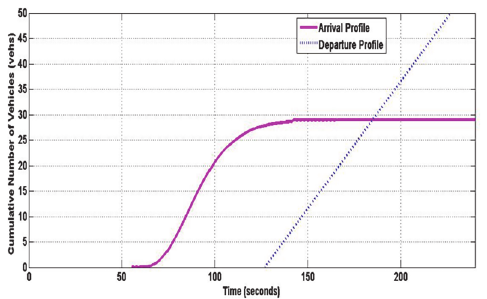
Fig 12. Arrival and departure profile.